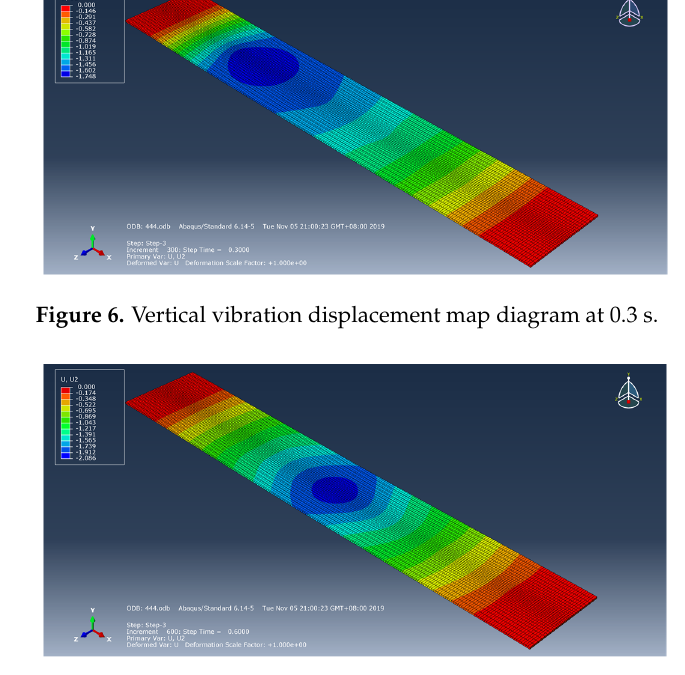
Figure 7. Vertical vibration displacement map diagram at 0.6 s.